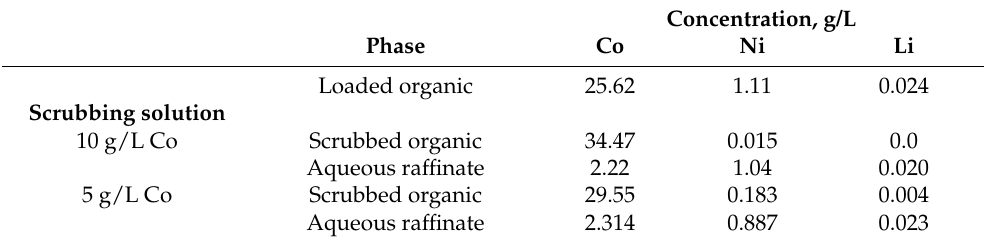
Table 4. Composition of organic and aqueous phases in scrubbing of Cyanex 272 using cobalt sulfate solutions at O/A ratio of 1:1 in a single stage.